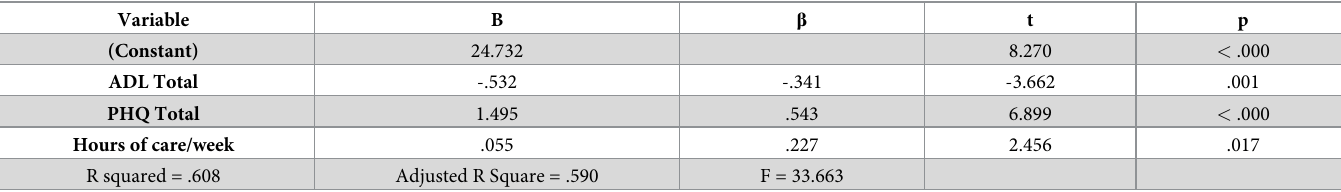
Table 5. Predictors of caregiver burden results of forward multiple linear regression